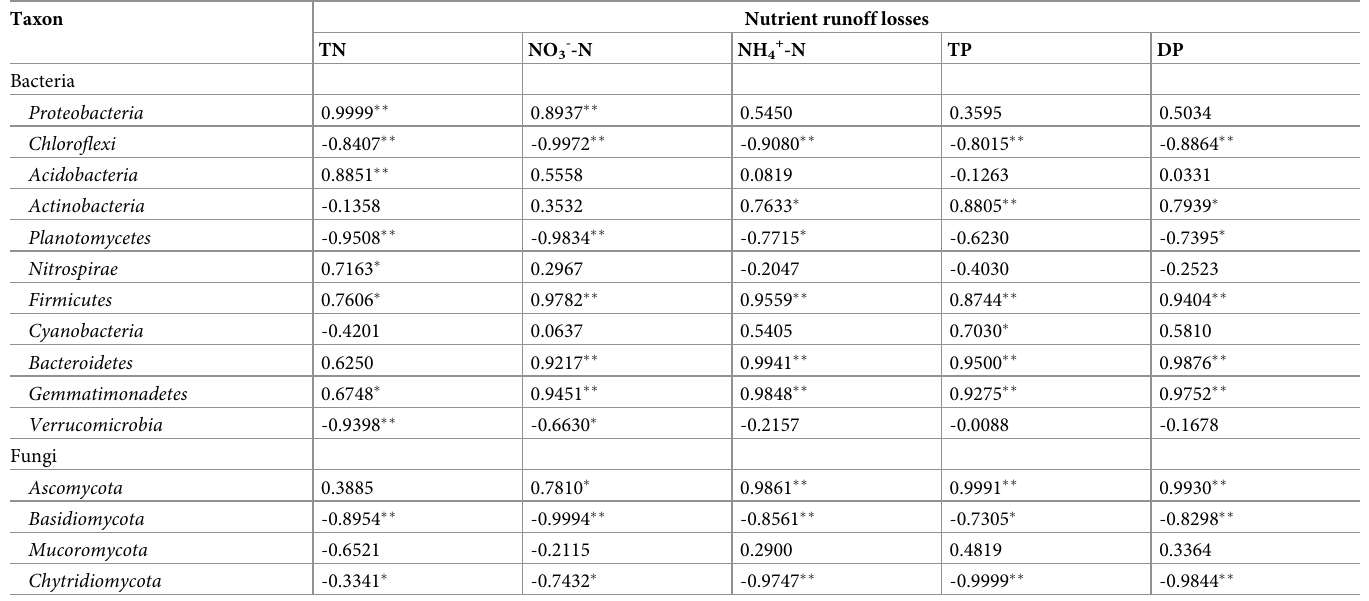
Table 5. Correlations of runoff losses of nitrogen and phosphorus and the abundances of bacteria and fungi.